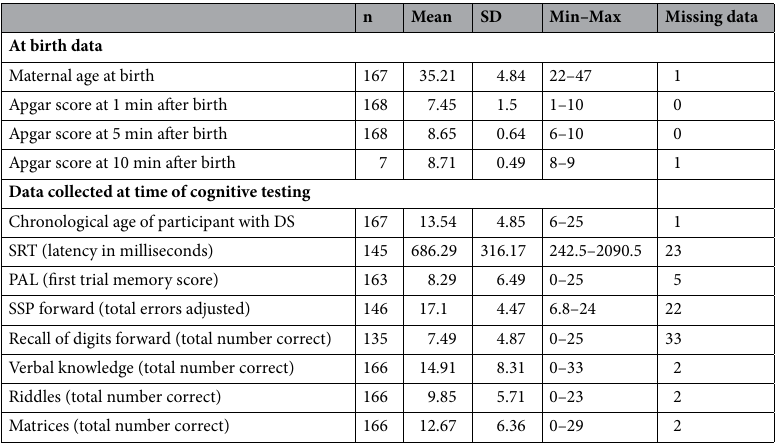
Table 2. Descriptive statistics of clinical and cognitive data of the 168 participants with DS. The first set of measures is related to the data collected at birth for the participants with DS. The second set of measures are those collected at the time of testing (6 to 25 years after birth). Results are described using central tendency (mean values) and variability (standard deviation and range) for numeric variables, and absolute and relative frequencies for categorical variables. Missing values were primarily due to administrative issues, technical issues, or the participant not being compliant. n number of participants, SD standard deviation, min minimum value reported, max maximum value reported, DS Down syndrome, SRT simple reaction time, PAL paired- associates learning, SSP spatial span.